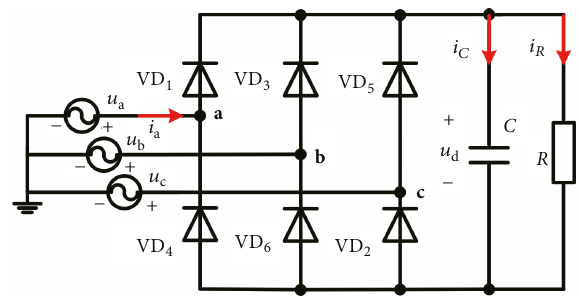
Figure 2: Three-phase diode bridge rectifier